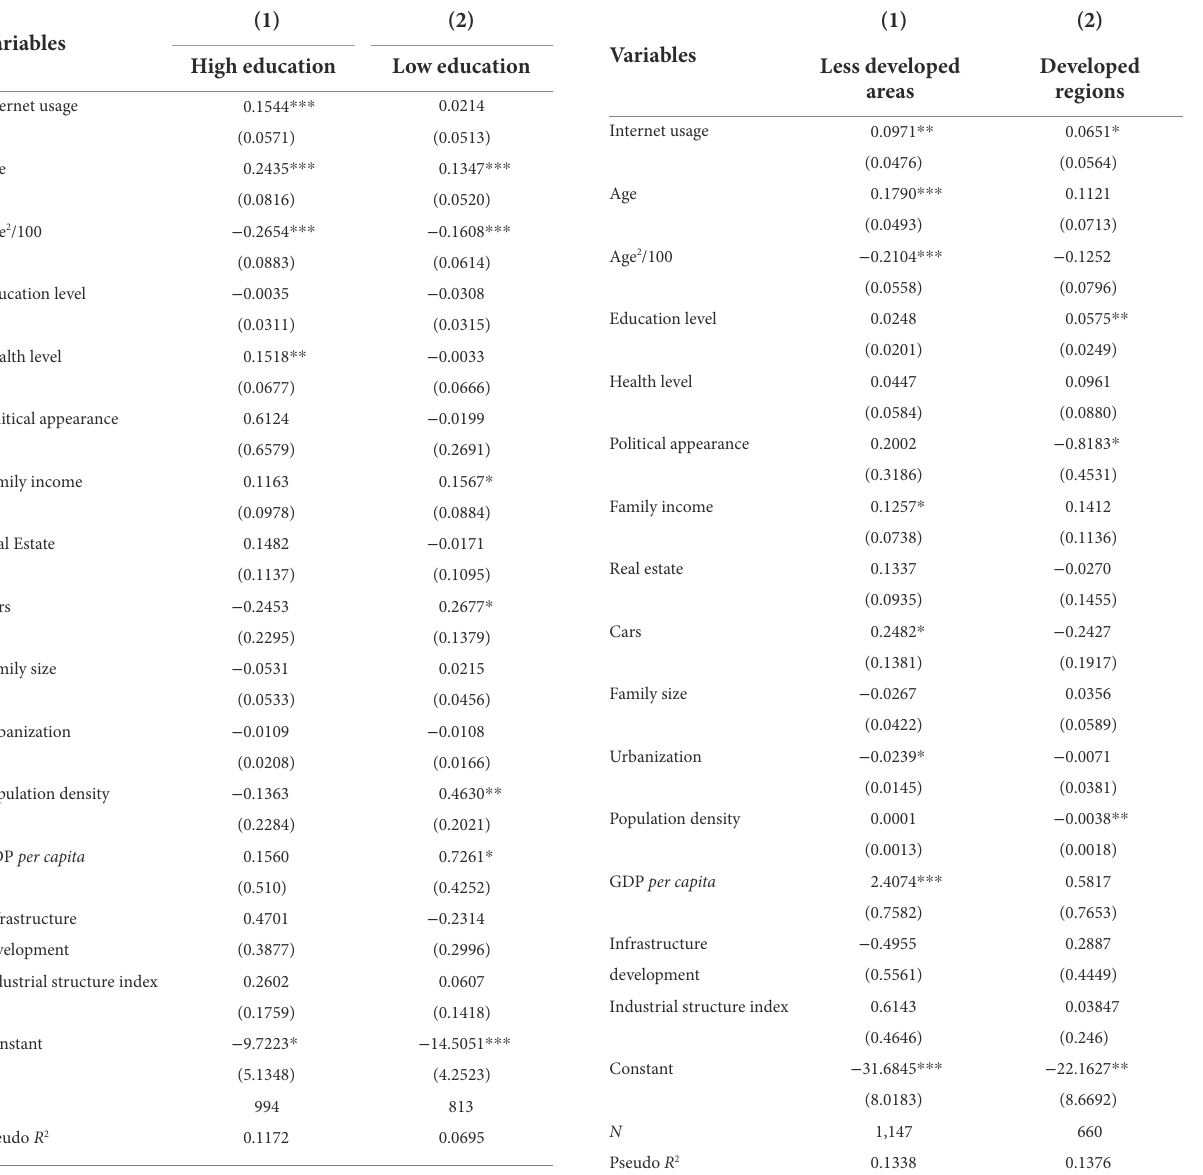
TABLE 6 Different entrepreneurial environments. TABLE 5 Different education